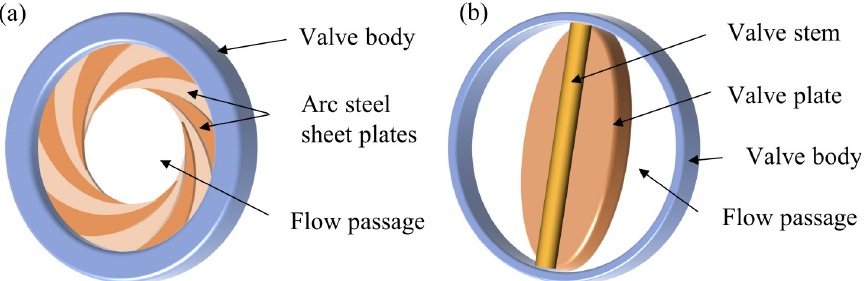
Fig 1. Three-dimensional simplified geometric models of two regulating valves. (a) Air-ring flow regulating valve. (b) Center butterfly